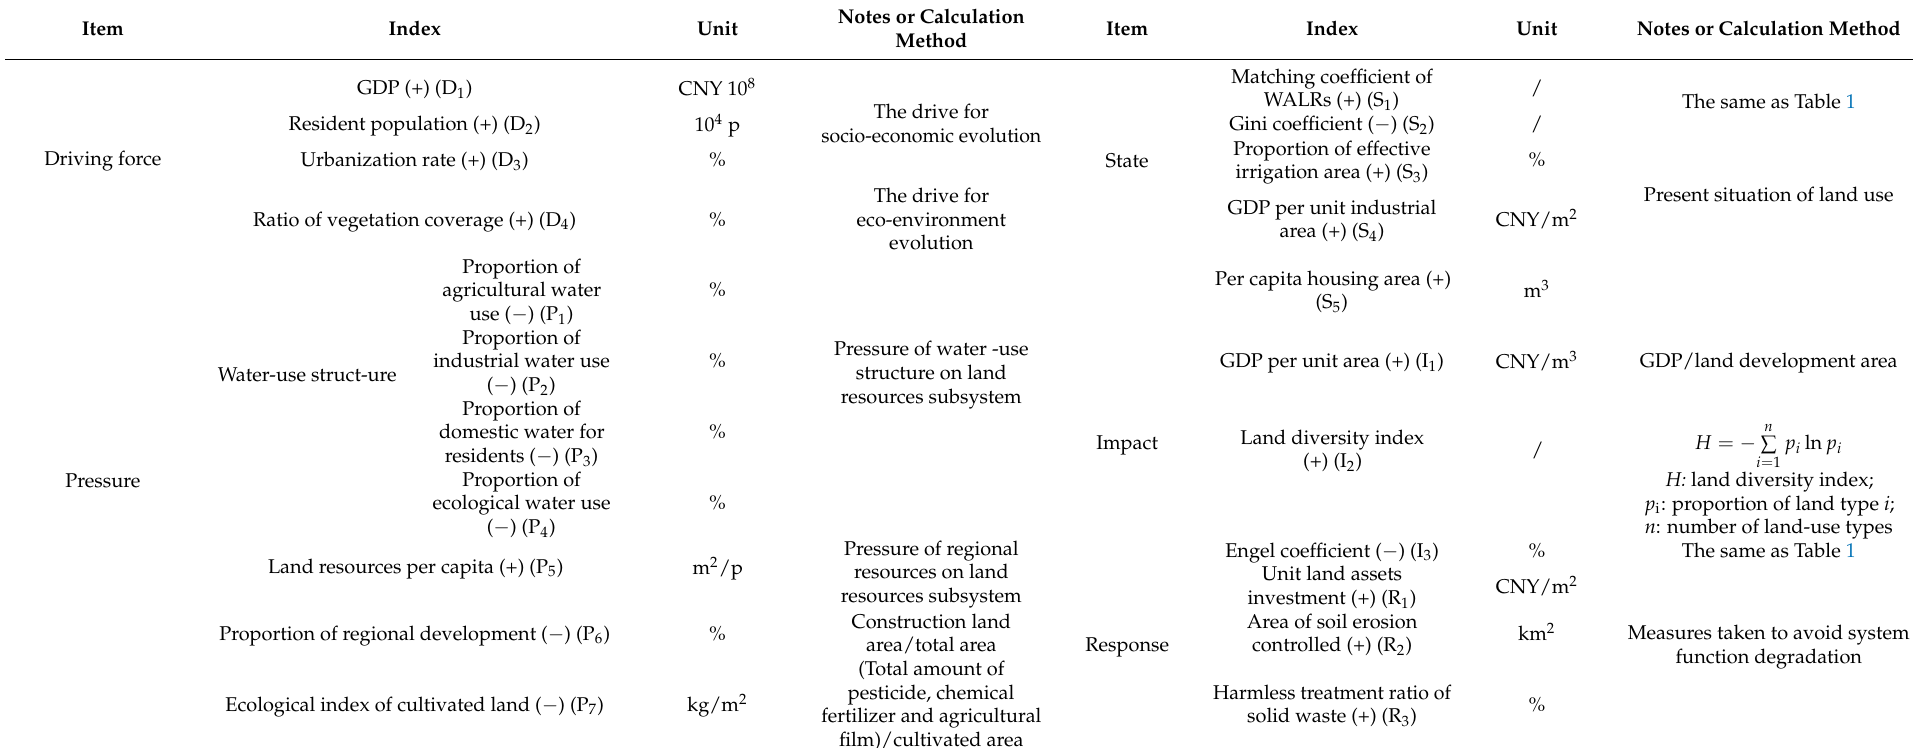
Table 2. Evaluation index system of synergistic development of land